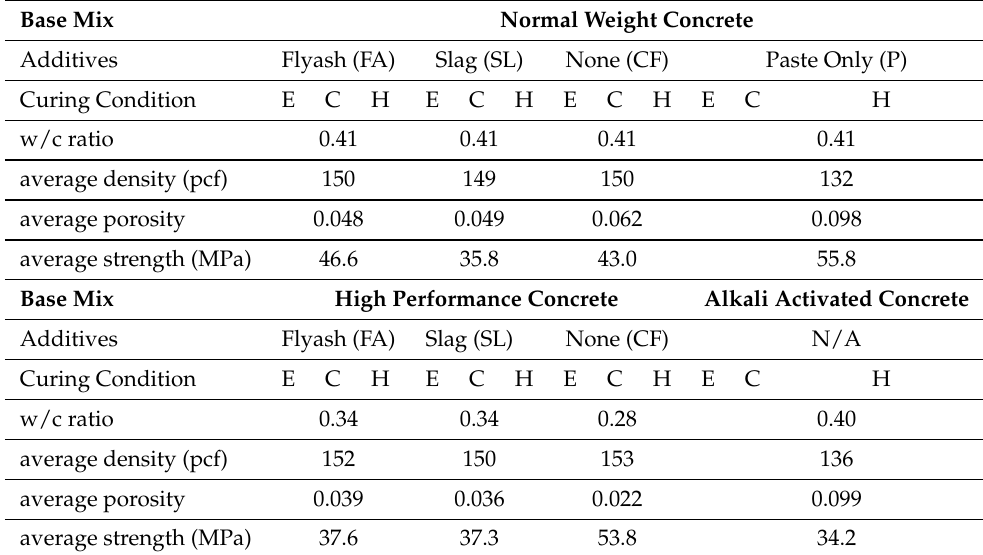
Table 1. Concrete beam sample details; curing conditions were exposed (E), covered (C), and kept at constant relative humidity